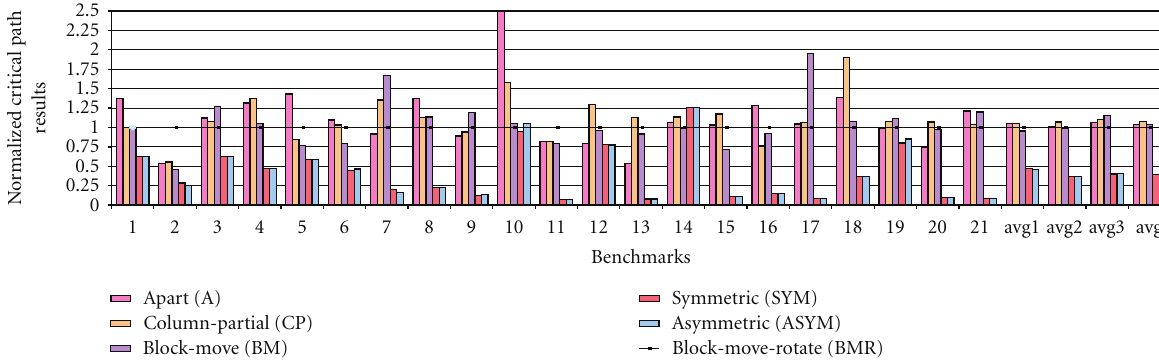
Figure 13: Critical path comparison between di ff erent techniques of mesh- and tree-based architectures.